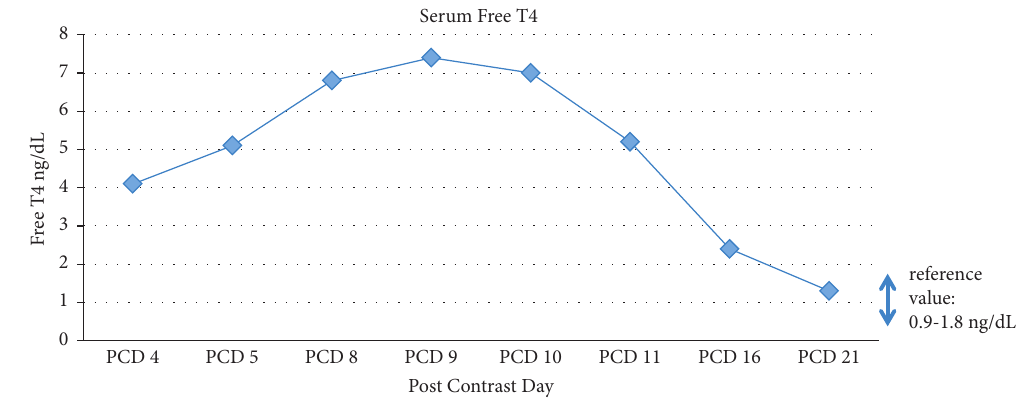
Figure 1: Serum Free T4 level in case study patient.